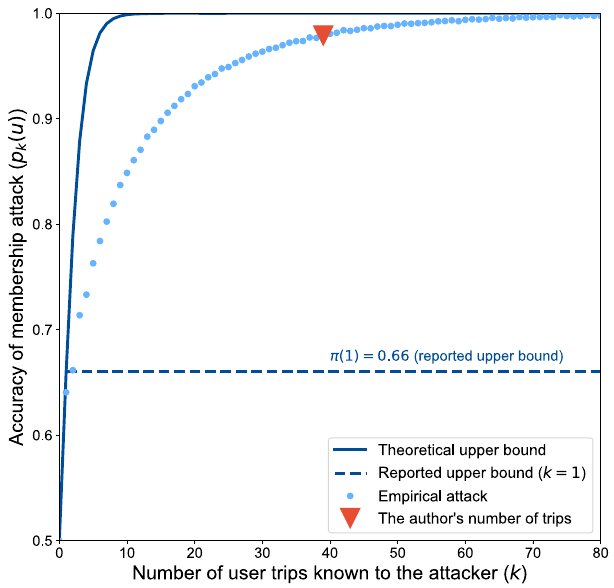
Fig. 1 The accuracy of the attack increases steeply with attacker knowledge and is higher than the reported upper bound. Empirical accuracy of a membership attack (dots) and theoretical upper bound (solid line) as a function of the number of unique trips taken by a user. Reported upper bound (dashed line) and empirical accuracy of the attack on one of the authors ’ data